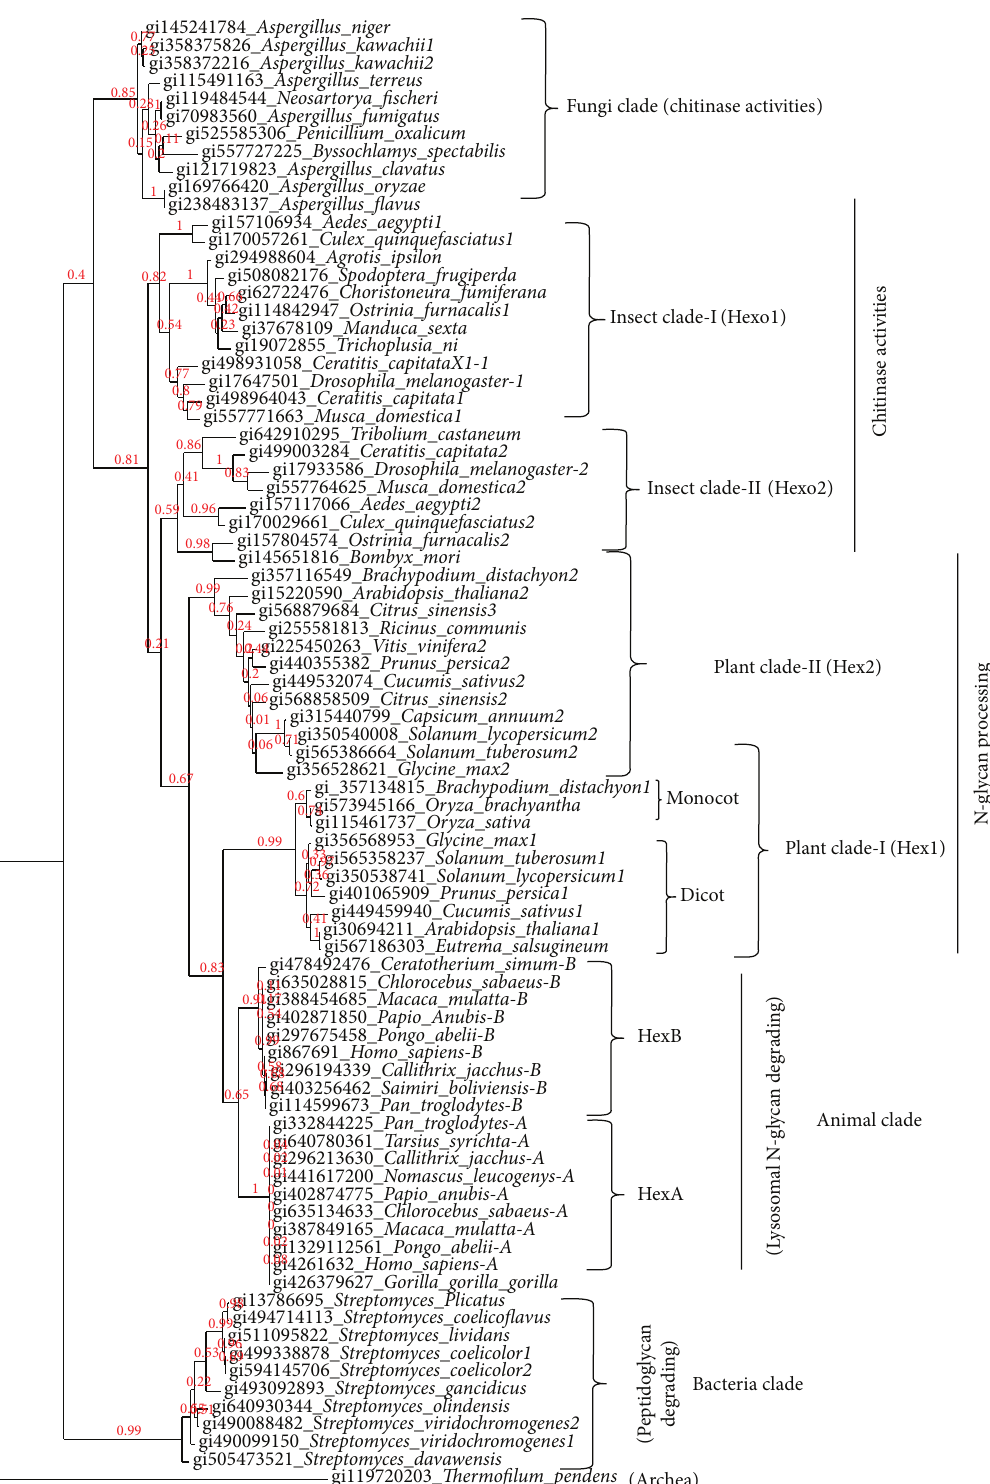
Figure 3: The phylogenetic tree based on beta -hexosaminidase amino acid sequences obtained by the maximum likelihood method. Thermofilum (Archea) was used as an outgroup to reconstruct the phylogenetic tree. The percentage of replicate trees in which the associated taxa clustered together in the bootstrap test (100 replicates) is shown next to the branches. All analyses were performed with the WAG amino acid substitution model and 1 invariable and 4 gamma distributed site rate categories. Detailed information about the sequences is shown